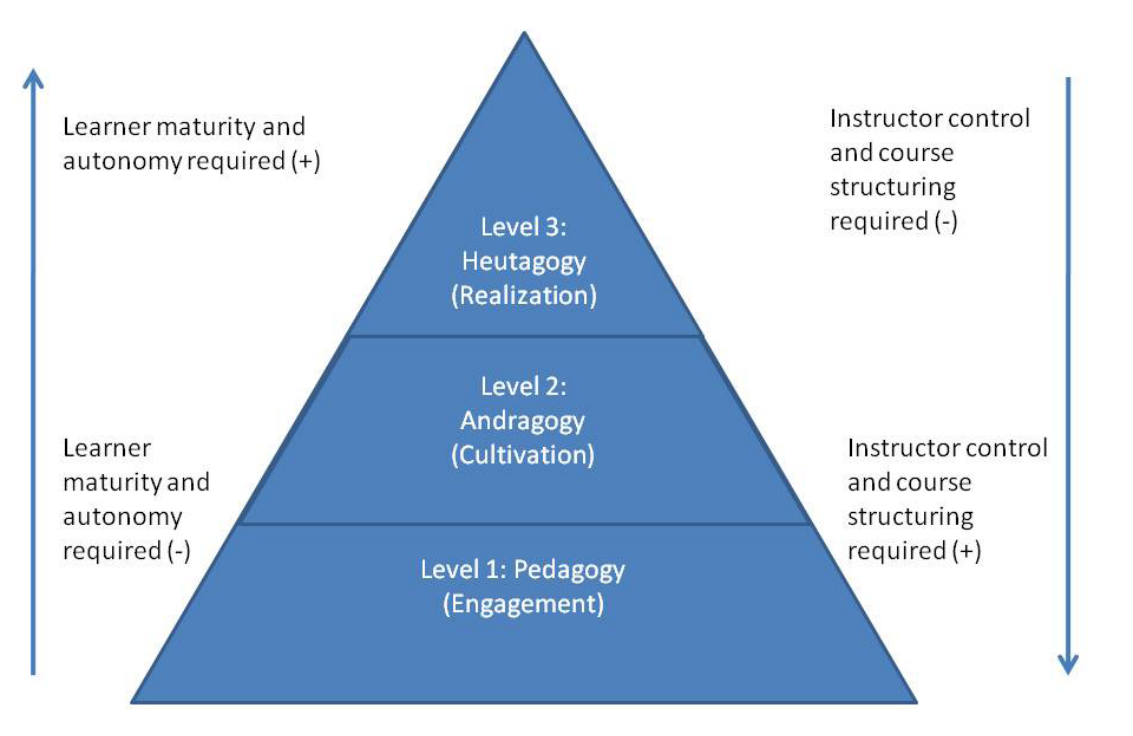
Figure 2. Progression from pedagogy to andragogy then to heutagogy (based on Canning, 2010, p.